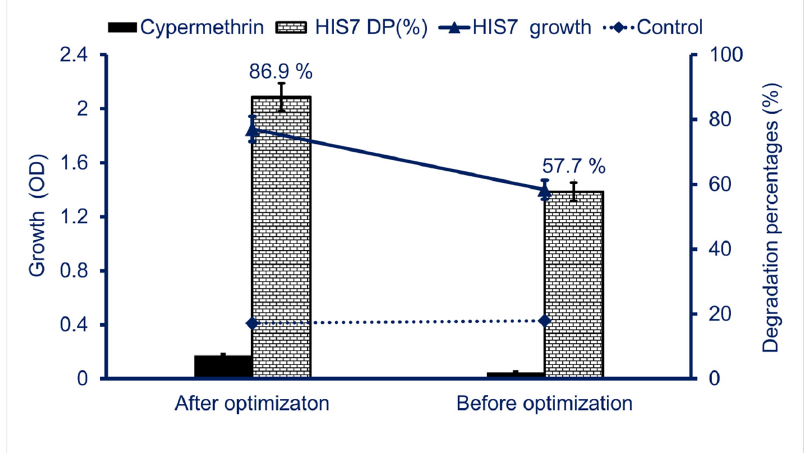
Figure 5 . The comparative study between biodegradation percentages of cypermethrin using Lysinibacillus cresolivuorans strain HIS7 before and after environmental factors optimizations. The environmental factors before optimization were incubation period 8 days at shaking condition, 2500 ppm of cypermethrin as only carbon source, incubation at 37 °C, and pH value of 7, whereas the environmental factors after optimization were incubation period 8 days at static condition, 2500 ppm of cypermethrin, incubation temperature was 35 °C, pH value was 7, 3% inocula volume, and in presence of glucose and NH 4 Cl 2 as extra-carbon and nitrogen source, respectively. Data represented by Mean ± SE (n = 3).